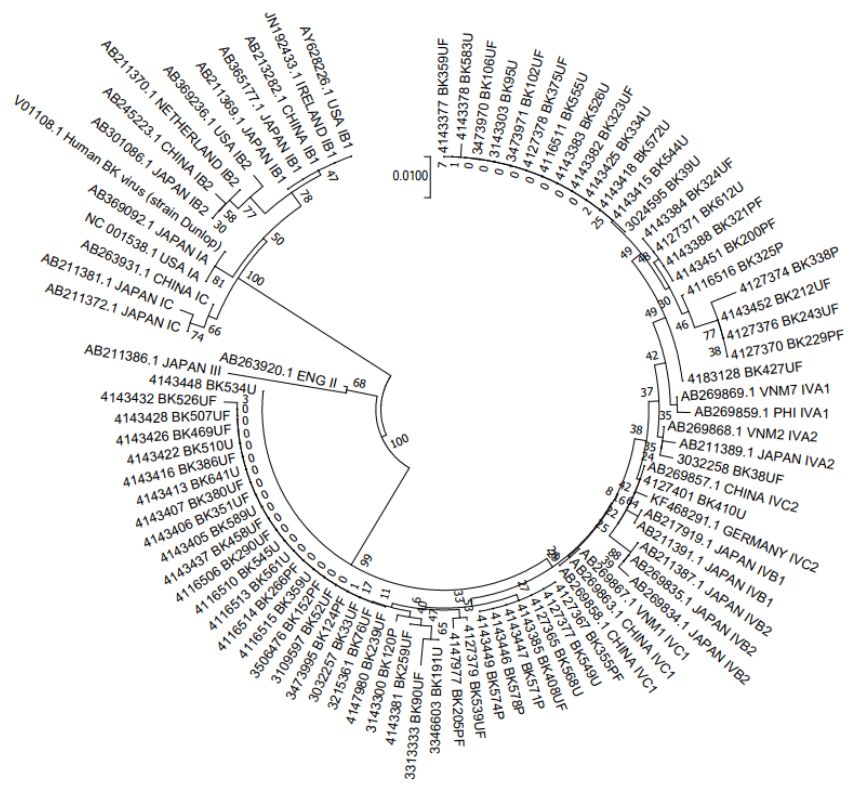
Figure 2. NJ phylogenetic tree clustering 60 BKV-IV polyomavirus sequences to determine subgroups.